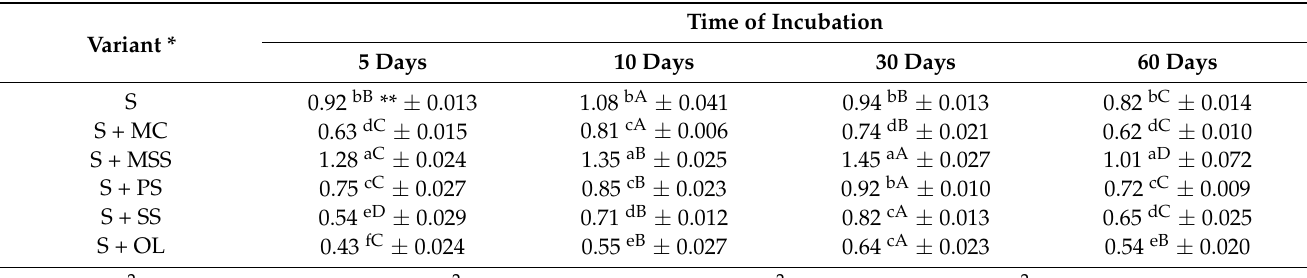
Table 5. The activity of catalase CAT (mg H 2 O 2 kg − 1 h − 1 ).